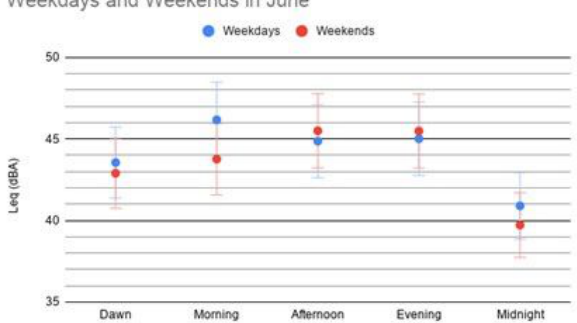
Figure 2: Comparison of the day history of noise levels (L Aeq , T = 1 min) on weekdays (blue) and weekends (red) in June. The plot for each time block is the averaged value over all weekdays and week- ends during the observation period. Error bars are also indicated (95%